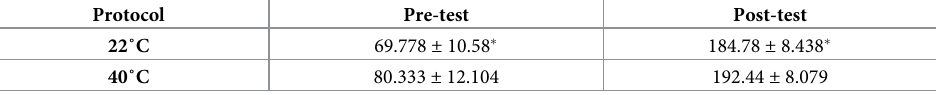
Table 2. Mean values followed by their respective standard deviations of heart rate (bpm) pre-test and post-test in 22˚C and 40˚C